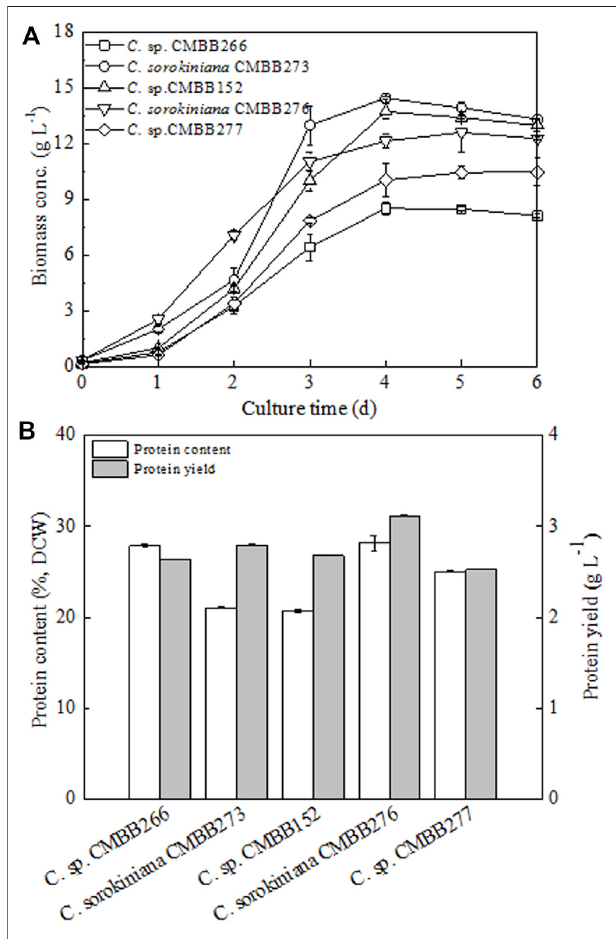
FIGURE 1 | Comparison of cellular growth rates (A) , protein contents, andyields (B) of fi ve Chlorella trainsunderheterotrophicculture.Cellsonday6 were harvested for protein analysis. Values are shown as mean ± SD from three biological independent